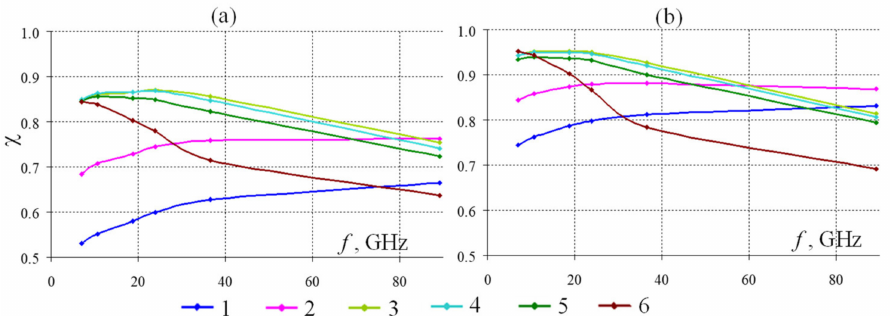
Figure 3. Dependence of winter averaged (calculated on the basis of data for January–May and for November and December 2020) sea ice emission coefficient χ on frequency f for the 6 Arctic sea ice types: ( a ) with horizontal polarization; ( b ) with vertical polarization: 1—nilas, 2—young ice, 3—thin FY, 4—medium FY, 5—thick FY, 6—MY